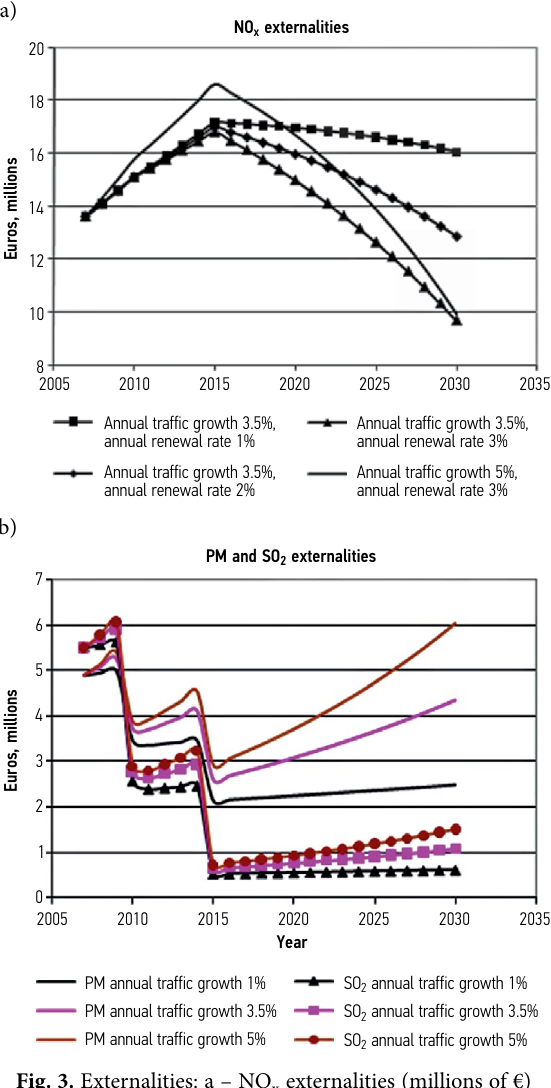
Fig. 3 evaluates the impact of changes in the an- nual traffic growth (concerning NO , PM and SO ) and x 2 ship fleet renewal rate (concerning NO ) on the result- x ing externalities using different CO2 scenarios (combi- nations of the traffic growth rate and/or fleet renewal rate). For NO (Fig. 3a), a traffic growth rate of 3.5% is x combined with 1, 2 and 3% fleet renewal rates causing a 20% decrease in the externalities of the year 2030 for an increase in every 1% of the renewal rate. Finally, a higher traffic growth rate of 5% is combined with a fleet growth rate of 3% which causes no significant changes in externalities in 2030. For PM and SO (Fig. 3b), by 2 2030, traffic growth rates of 1%, 3.5% and 5% will have resulted in the externalities of €2.5 million, €4.3 million and €6 million for PM, and €0.5 million, €1.1 million and €1.5 million for SO respectively. 2